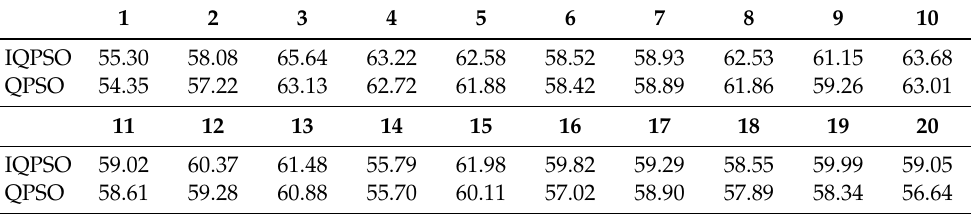
Table 3. Comparison of TSCNS